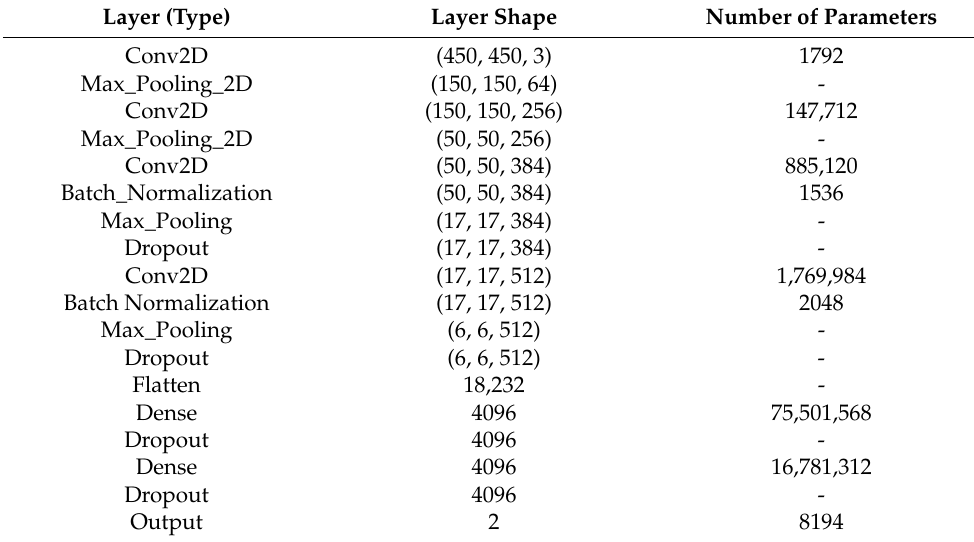
Figure 9. The architecture of CNN (ALLNet). Table 2. ALLNet Architecture .